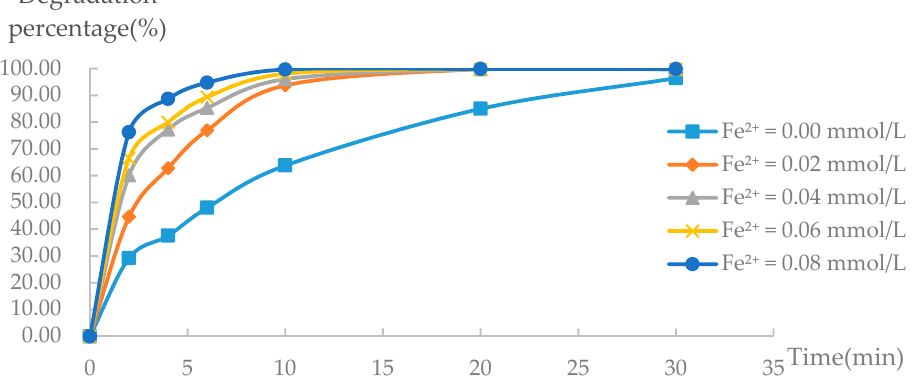
Figure 5. The influence of Fe 2+ concentration (0–0.08 mmol/L) on trimethoprim degradation.